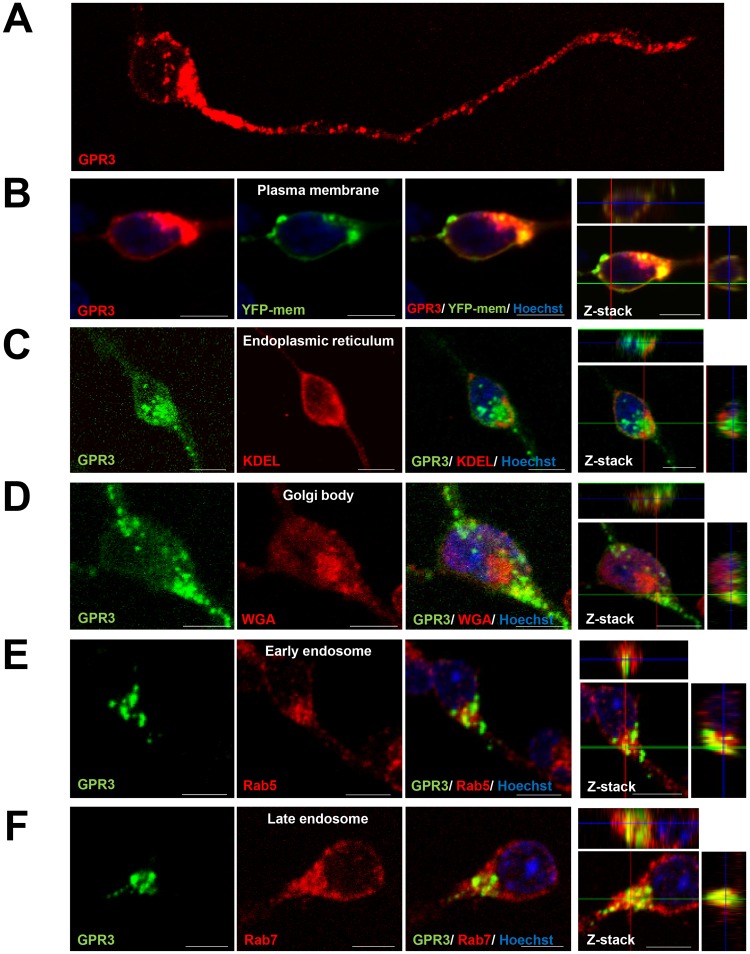
The subcellular distribution of fluorescently tagged GPR3 in CGNs.(A) We employed a GPR3-HT expression vector to analyze the localization of GPR3. After transfecting the GPR3-HT vector into the CGNs, the cells were labeled with the TMR HaloTag ligand at forty-eight hours after transfection. A representative image was shown. (B) To evaluate the localization of GPR3 at the plasma membrane, the CGNs were co-transfected with the GPR3-HT and YFP-mem expression vectors, followed by TMR HaloTag ligand labeling. YFP-mem fluorescence was shown in the green pseudo-color to easily visualize the co-localization. (C-F) To evaluate the localization of GPR3 in the endoplasmic reticulum, Golgi body, and endosomes, the GPR3-mAGFL expression vector was transfected into the CGNs. Forty-eight hours after transfection, the cells were immunostained with various organelle markers: anti-KDEL antibody (endoplasmic reticulum), WGA633 (Golgi body), anti-Rab5 antibody (early endosome), and anti-Rab7 antibody (late endosome). Co-localization of GPR3 with the organelle markers was evaluated by confocal microscopy using built-in Z-stack analysis software. Scale bar = 10 μm.